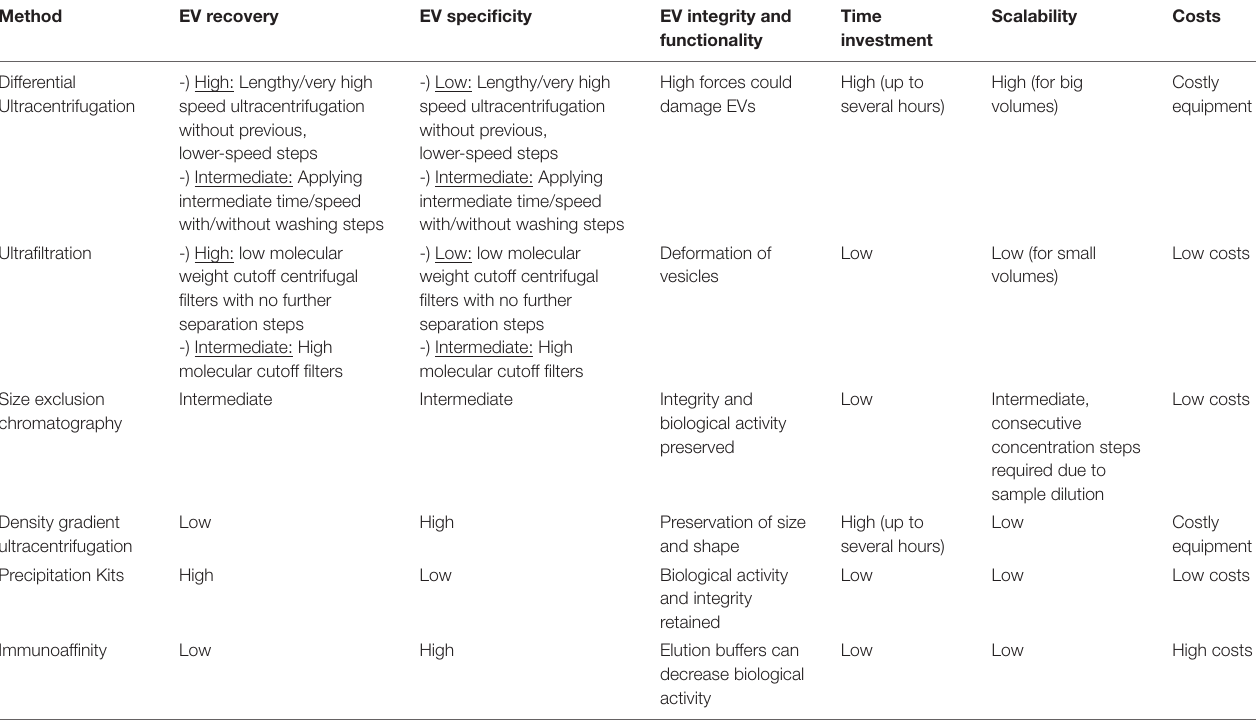
TABLE 1 | Comparison of advantages and disadvantages of various methods for EV enrichment.